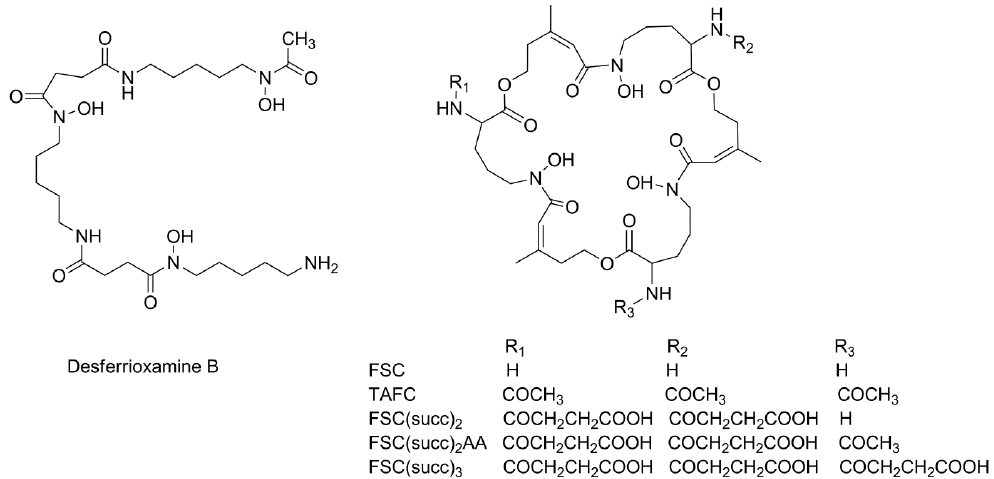
Figure 1. Structures of desferrioxamine B (DFO), fusarinine C (FSC), triacetylfusarinine C (TAFC), FSC(succ) 2 , FSC(succ) 2 AA and FSC(succ) 3 .